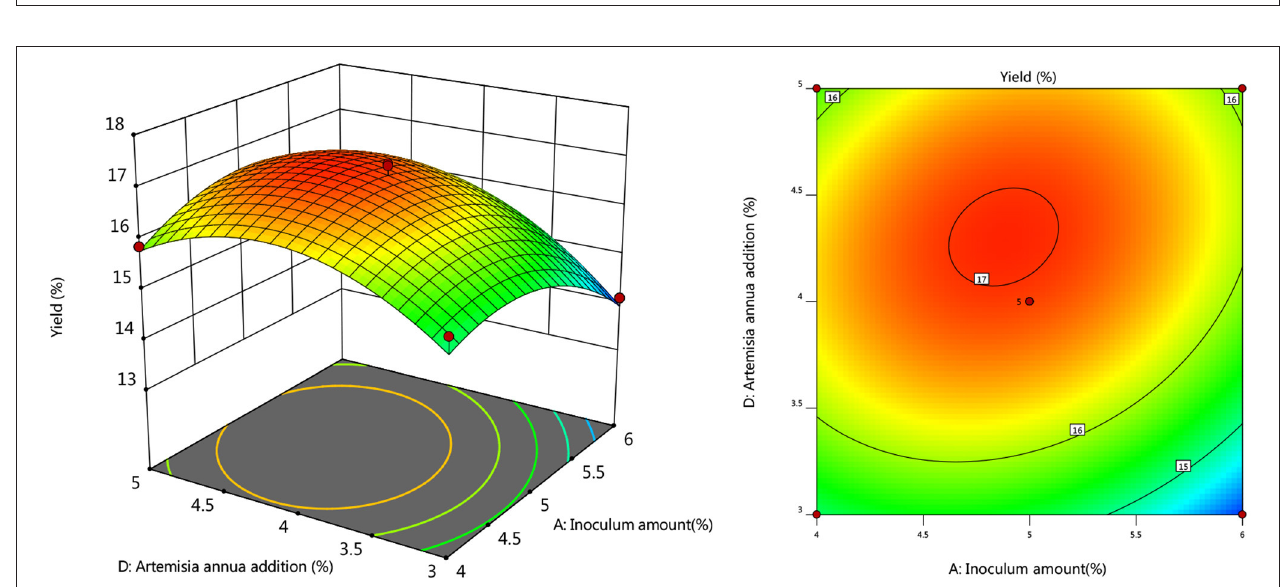
FIGURE 7 | Response plots for the interaction of inoculation volume and time on yield.